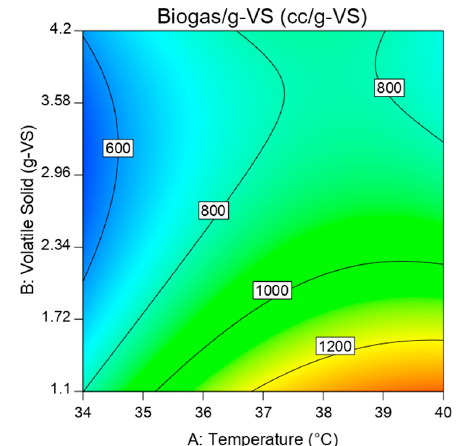
Figure 8. Contour plot views the effect of temperature and volatile solid on the biogas g –1 -VS volume at sludge quantity of 37.5%.